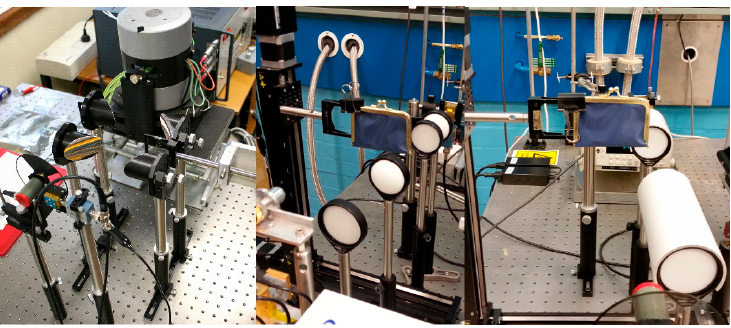
Figure 1. Examples of the system improvement steps with varied hardware and the beam guiding